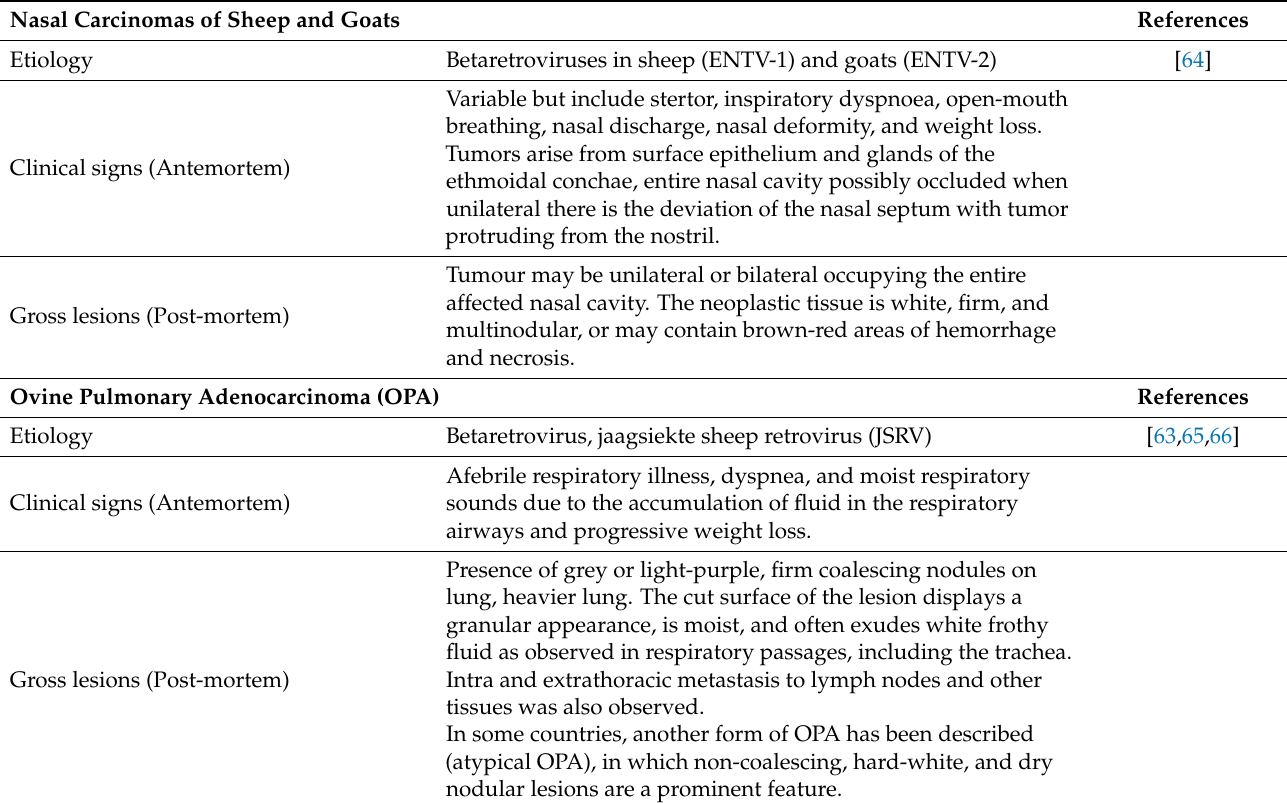
Table 3. Clinical signs and gross lesions associated with nasal carcinoma and pulmonary adenocarcinoma were observed in emaciated carcasses from small ruminants. Nasal Carcinomas of Sheep and